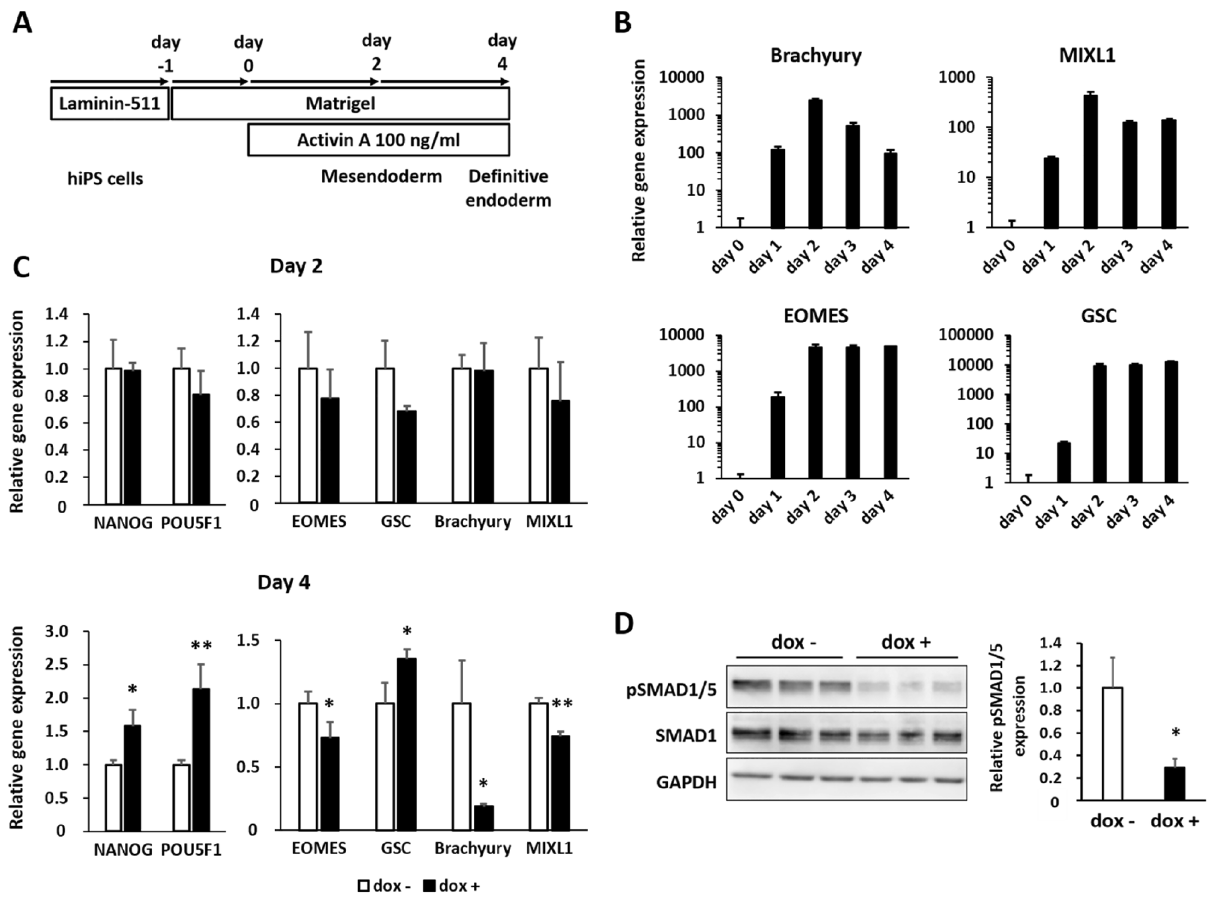
Figure 2. miR-27b expression induced in the differentiation stage reduced expression of mesendodermal genes. ( A ) Differentiation procedures. hiPS cells are seeded on Matrigel-coated plates and precultured for 1 day. Activin A (100 ng/ml) was added from day 0. hiPS cells were differentiated into mesendoderm at day 2 and definitive endoderm at day 4. ( B ) Expression levels of mesendodermal marker genes in hiPS-AAVS1-27b cells were analyzed by qRT-PCR in the time course of differentiation. The value of day 0 was taken as 1.0. Data are presented as mean ± SD (N = 3). The representative result from two independent experiments is shown. ( C ) Expression levels of differentiation marker genes in hiPS-AAVS1-27b cells were analyzed by qRT-PCR at day 2 (upper) and day 4 (lower) of differentiation. hiPS-AAVS1-27b cells were differentiated with or without dox (1 µg/ml). The value of dox- was taken as 1.0. Data are presented as mean ± SD (N = 3). Student’s t test was performed (*p < 0.05, **p < 0.01) The representative data from four independent experiments is shown. ( D ) Expression levels of phospho-SMAD1/5 protein in hiPS-AAVS1-27b cells at day 2 of differentiation were analyzed by Western blotting (left). Protein expression levels were quantitated and normalized by an internal reference, GAPDH (right). Original images are shown in Fig. S8A. The value of dox- was taken as 1.0. Data are presented as mean ± SD (N = 3). Student’s t test was performed (*p < 0.05). The representative result from four independent experiments is